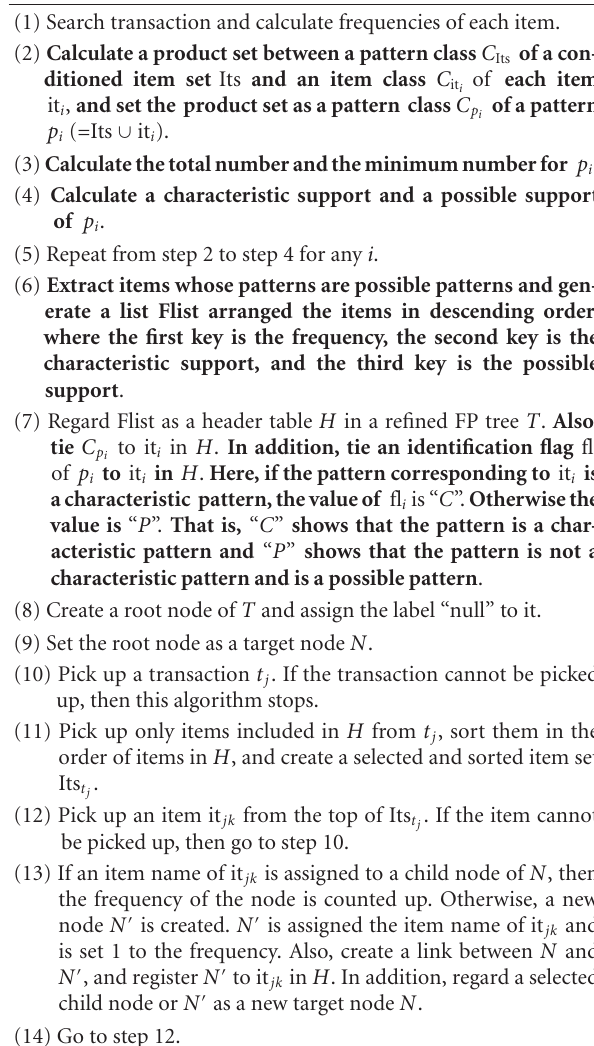
Table 6: A generation method of the refined FP